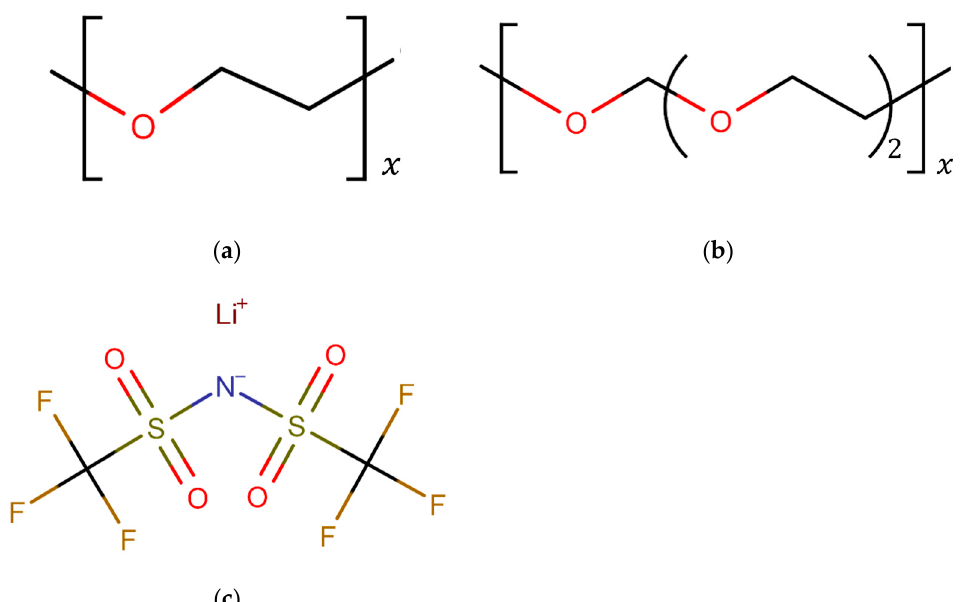
Figure 1. Structural formulas of ( a ) PEO, ( b ) (2EO-MO), and ( c ) the LiTFSI salt considered in the present simulations.